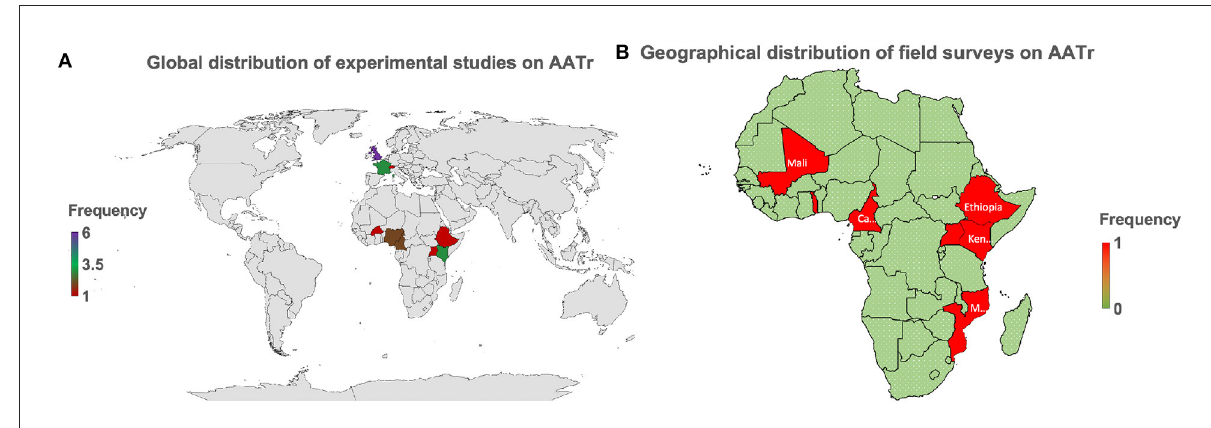
FIGURE2 AATr, African animal trypanocide resistance. (A) This provides the global perspective showing that emphasis on AATr is in Africa and Europe. (B) Field surveys are only taking place in Africa globally demonstrating why AATr continues to be a neglected tropical disease. Biomedical experiments have generally been spearheaded by collaborative institutions in Europe while Africa continues to lag in this field due to the low number of active experimental studies on the African continent on AATr (A) . This has subsequently translated to a continued lack of commitment by local African institutions to routinely conduct surveillance activities to monitor the development of drug resistance in their countries (B) . It is important to note that West and East African countries are more prepared on AATr than their African neighbors in Central and Southern Africa, which all lie within the endemic regions of the continent.